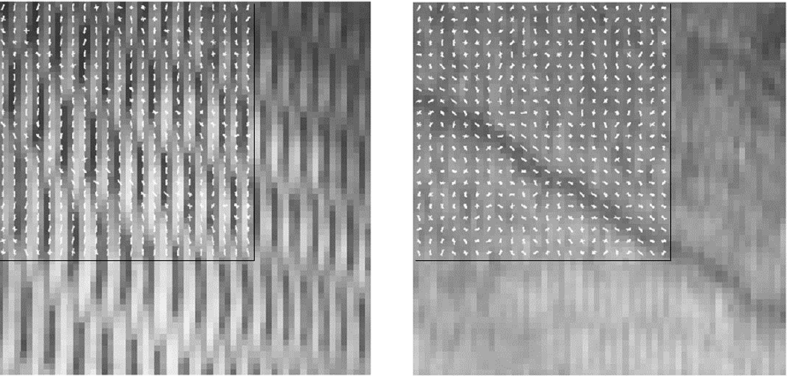
Figure 7. HOG visualization for ROIs. The left image is the ROI1 for carp resized to 64 by 64 pixels, where the white holes are the scales of the fish, and black lines are the connecting parts of the scales. The right image represents the ROI(LL) for seabass resized to 64 by 64 pixels, where the black line is the lateral line. The rectangle in the left-top corner of both images visualizes the HOG gradients used for pattern parametrization. The gradience are tiny white lines, which correspond to the orientation of the edges in the image. For common carp it follows the shape of the scale and for the seabass it follows the lateral line.